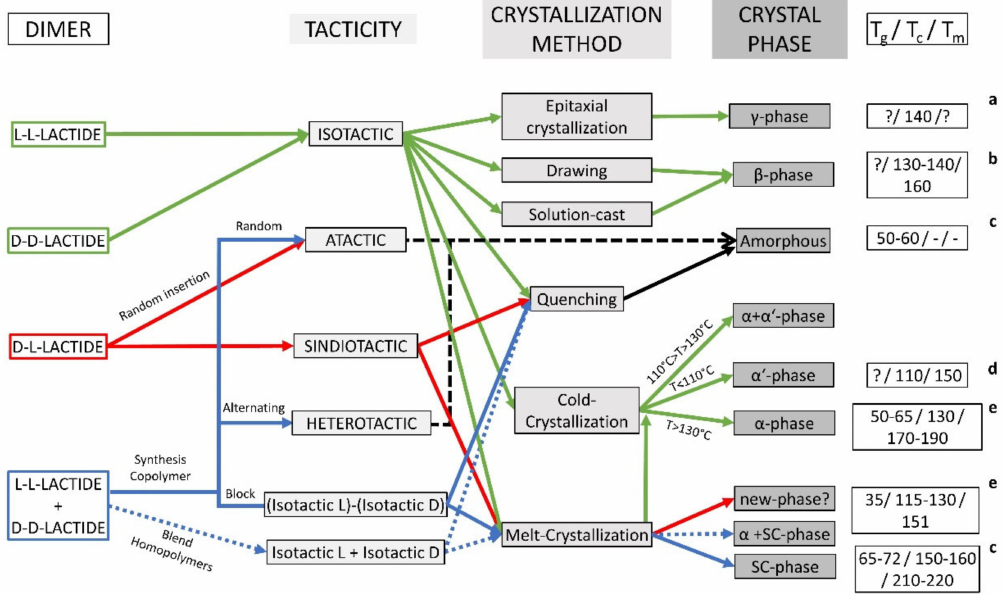
Scheme 1. Overview of the morphology attained by the different PLA derivatives depending on the processing conditions. Dimer refers to lactide dimer starting materials for ROP